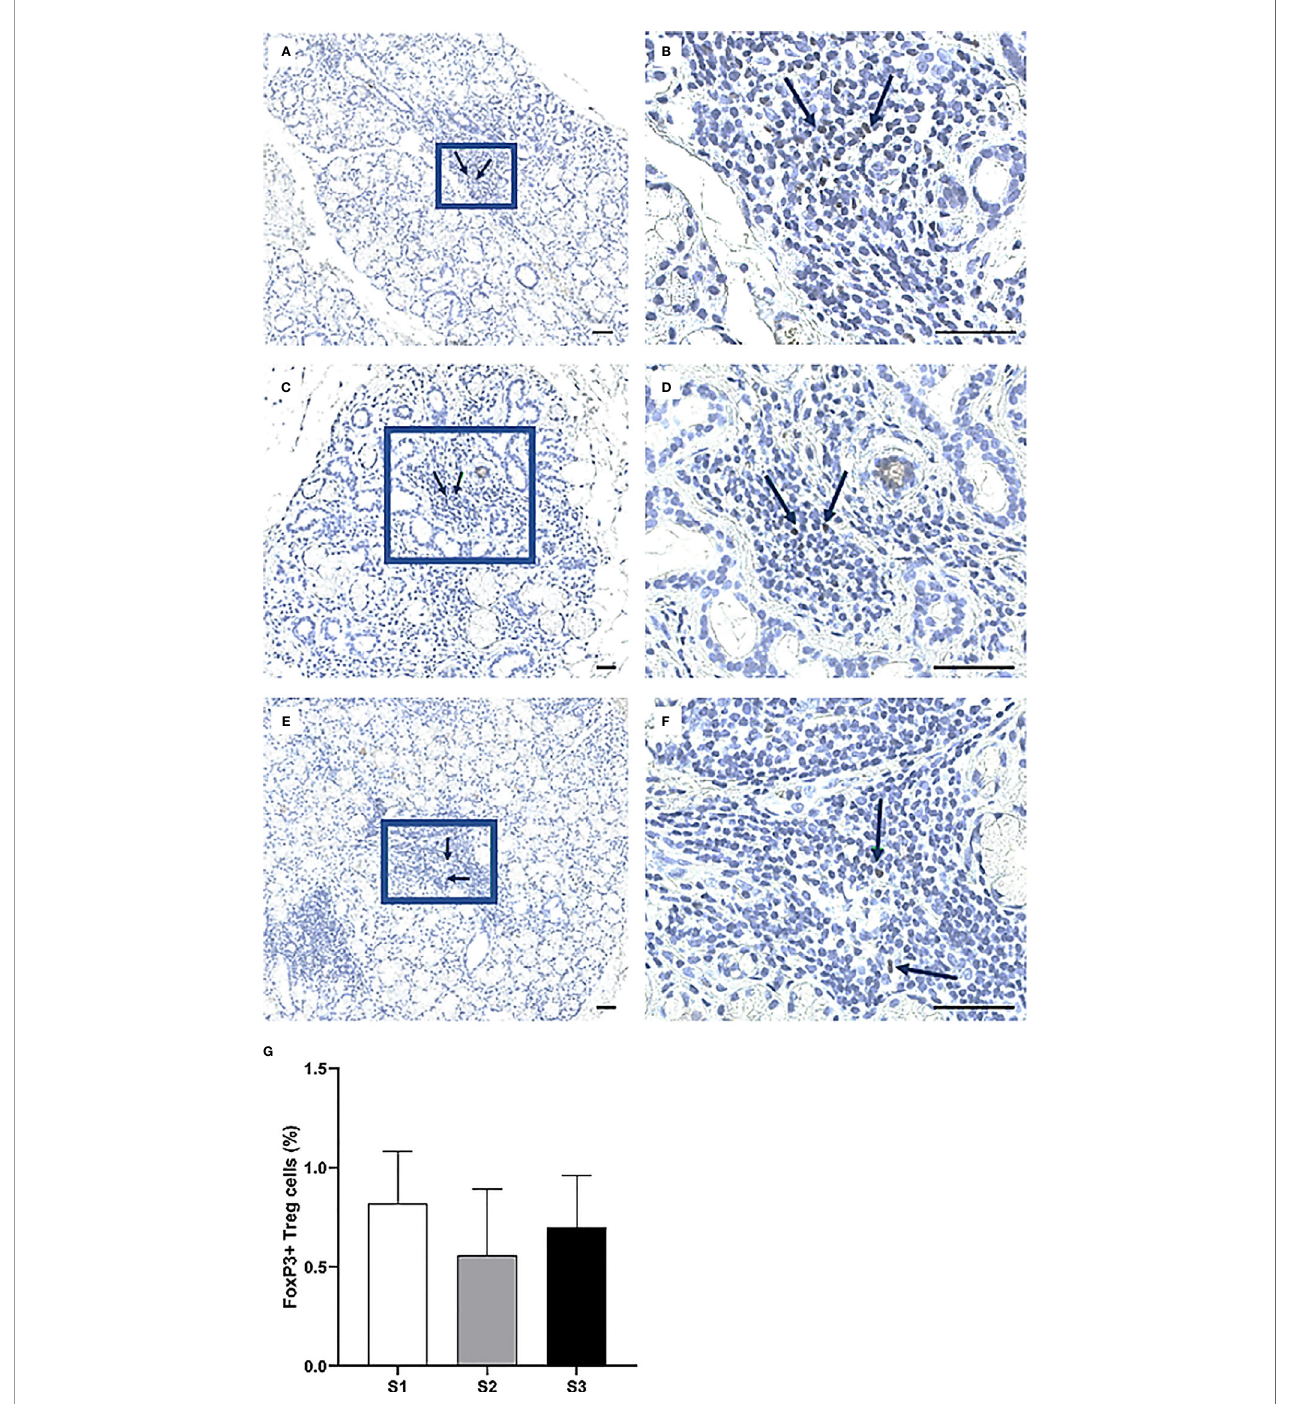
FIGURE 5 | Identi fi cation of FoxP3 + cells in the MSG of patients with pSS. Here, some of the detected FoxP3 + Tregs are indicated by arrows (A – F) . FoxP3 + cells were scarce or absent in the patients, particularly in the S2 group. Although the alternations in FoxP3 + cell-incidence in accord with in fl ammatory disease severity resembled that of CD4 + Th cells, no signi fi cant differences were noted for this subpopulation (G) . Immunohistochemical staining displaying the distribution of a speci fi c immune cell in three representative examples offocal in fi ltrates in the MSG as classi fi ed into the respective in fl ammatory severity stages; S1 (A, B) , S2 (C, D) , and S3 (E, F) . Image (B) is a magni fi cation of (A) , image (D) is a magni fi cation of (C) , image (F) is a magni fi cation of (E) . Scale bar = 0.5 mm. Bars (G) indicate the mean percentage of cell-type number/total in fi ltrating mononuclear cells in each stage and error bars represent ± SEM. The Student's T test was